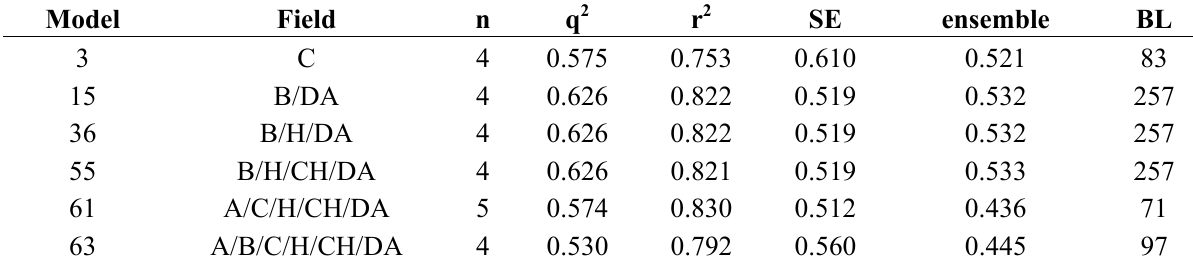
a Abbreviations as in Table 1.